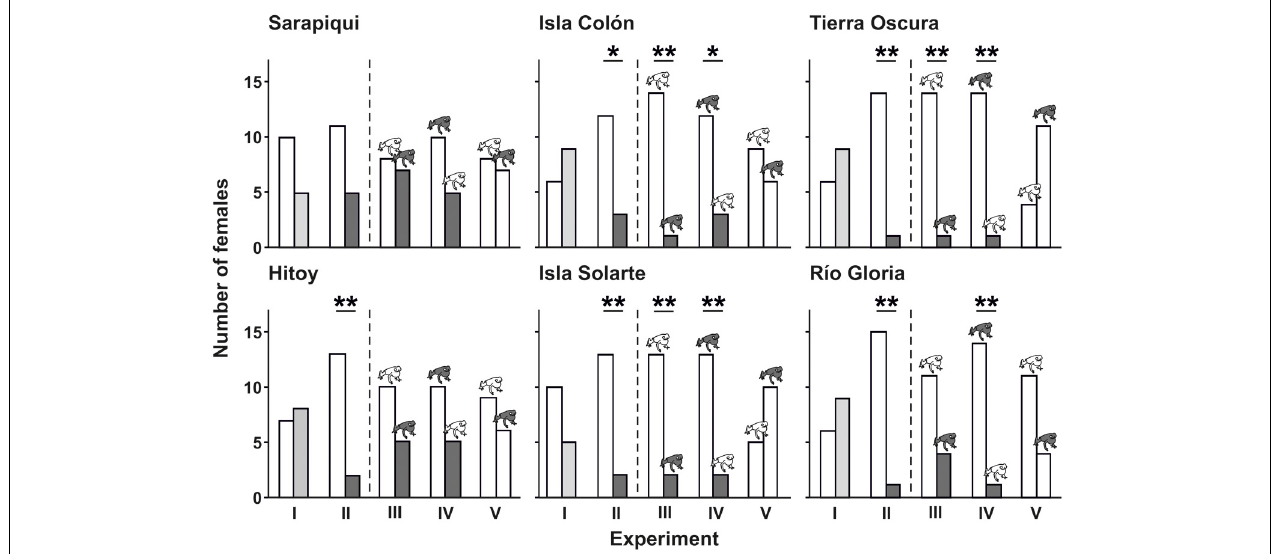
FIGURE 5 | Results of playback experiments for each population. The bars present the number of females which selected one or the other signal or signal combination. Bar coloration indicates call type, model frog coloration indicates model type presented in the